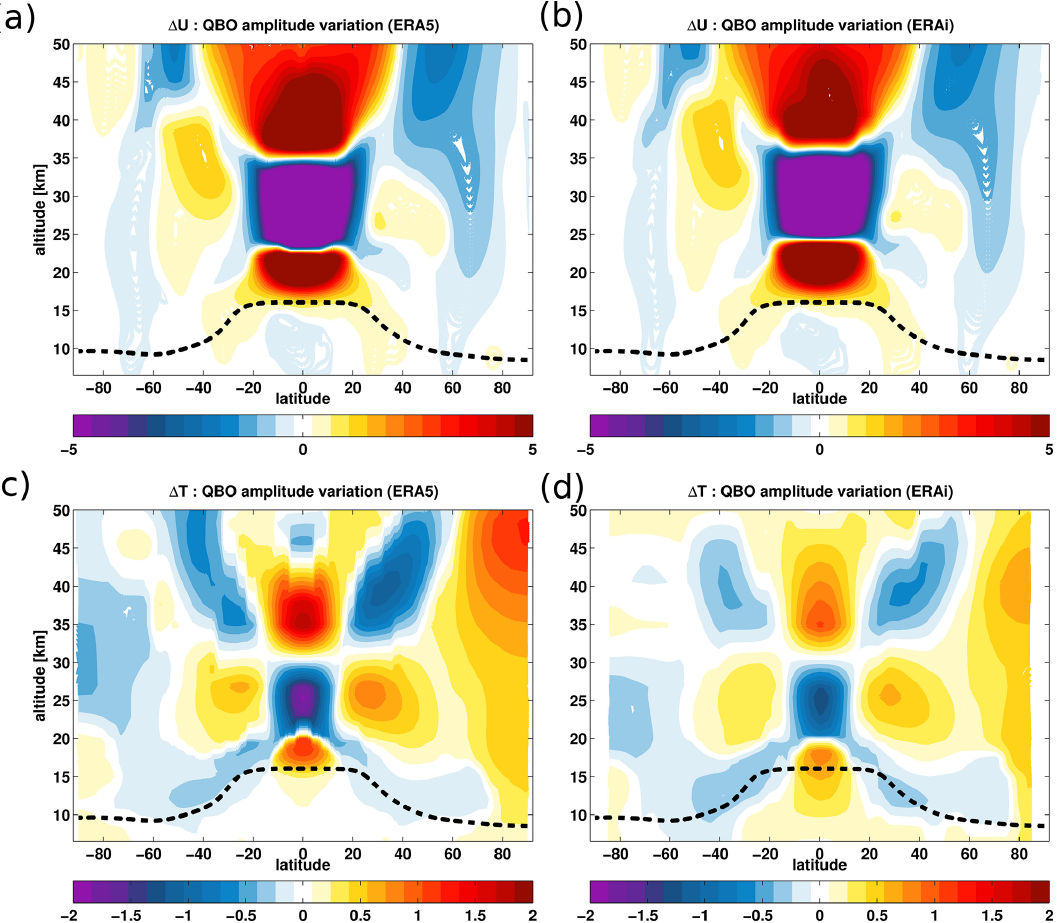
Figure 7. QBO amplitude variation derived from the ERA5 and the ERA-Interim zonal mean wind (a, b) and temperature (c, d) using the hybrid regression analysis for the 1979–2018 time period. The QBO amplitude variations are estimated by fitting the QBO predictor using the regression model (Eq. 10). The units of the QBO amplitude variations are metres per second and kelvin (ms − 1 and K). In (a) and (b) , the easterly QBO shears and winds are in blue, while the westerly QBO shears and winds are in red. The climatological tropopause from the ERA-Interim is shown in the dashed black horizontal